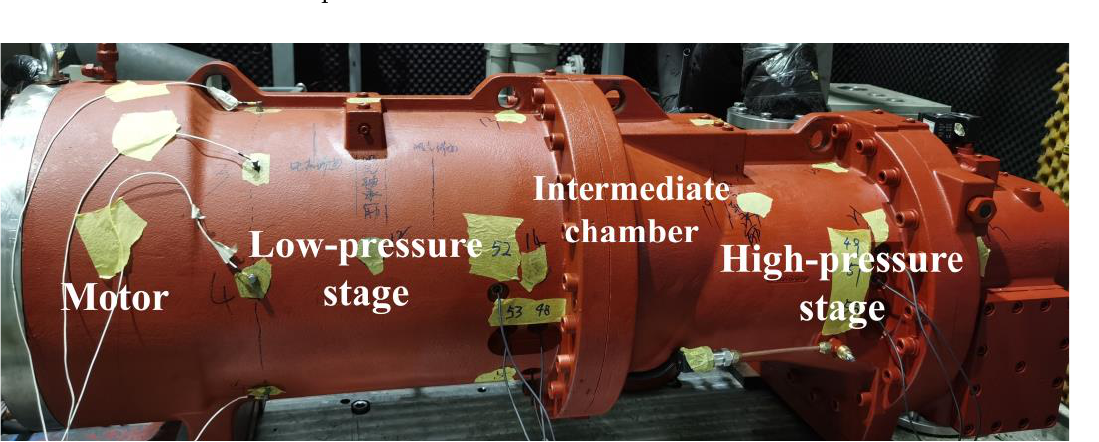
( b ) Figure 12. Photos of refrigerant compressor test system: ( a ) the front view; ( b ) the back view. The refrigerant circulation process of this test system is as follows: the compressor discharge enters the oil separator first and is then divided into two paths. One path enters the condenser for heat exchange and condensation with the cooling water. The condensed refrigerant liquid is throttled and depressurized by the liquid valve after passing through the accumulator and sub-cooler. It is then mixed with the other path of the high-temper- ature refrigerant gas depressurized by the gas valve, and then it enters the mixer for heat exchange. The low-pressure and low-temperature refrigerant vapor produced enters the refrigeration compressor for compression. In addition to the refrigerant circulation, this test system also includes cooling water circulation and oil circulation. The cooling water circulation is as follows: The low-temperature cooling water enters the condenser to ab- sorb heat and liquefy the refrigerant. After its temperature rises, the water flows out of the condenser and enters the cooling tower to exchange heat with the air for cooling. The low-temperature cooling water is pumped into the condenser by the cooling water pump. The oil circulation is as follows: The oil separated from the oil separator is cooled by the oil-cooling plate heat exchanger and the oil cooling unit. Then, the oil ’ s temperature is